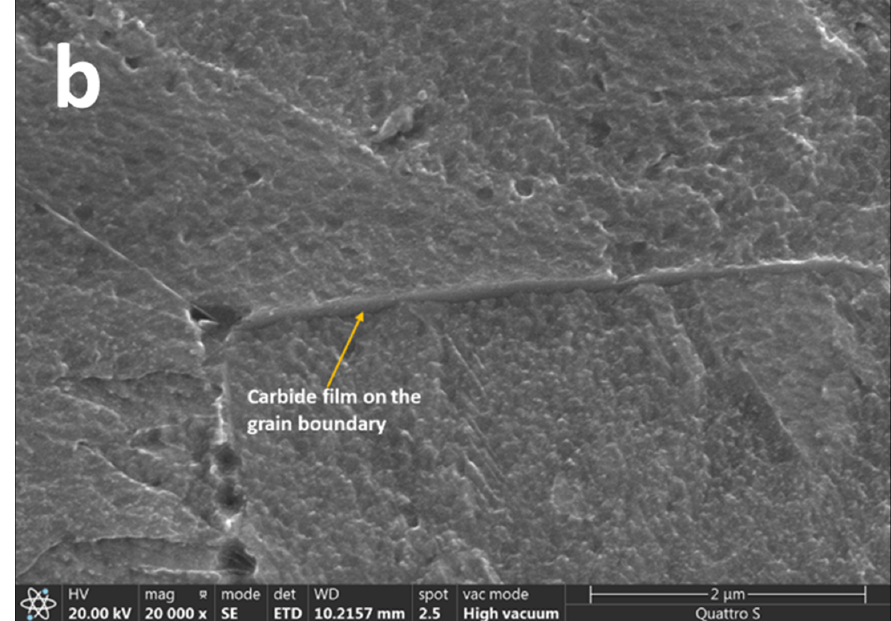
Figure 8. A thin carbide film on the grain boundaries in the sample quenched from 1000 °C ( a ) lower magnification, ( b ) higher magnification of the carbide film; SEI.